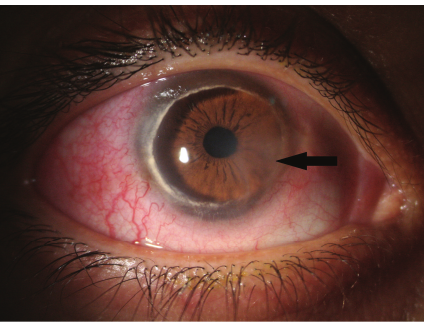
Figure1:Photographoftherighteyeshowingconjunctivalinjection and circumferential peripheral gutter with opacification, lipid depo- sition, and vascularization. Mild edema also noted in the inferior- nasal portion of the cornea (solid black arrow).